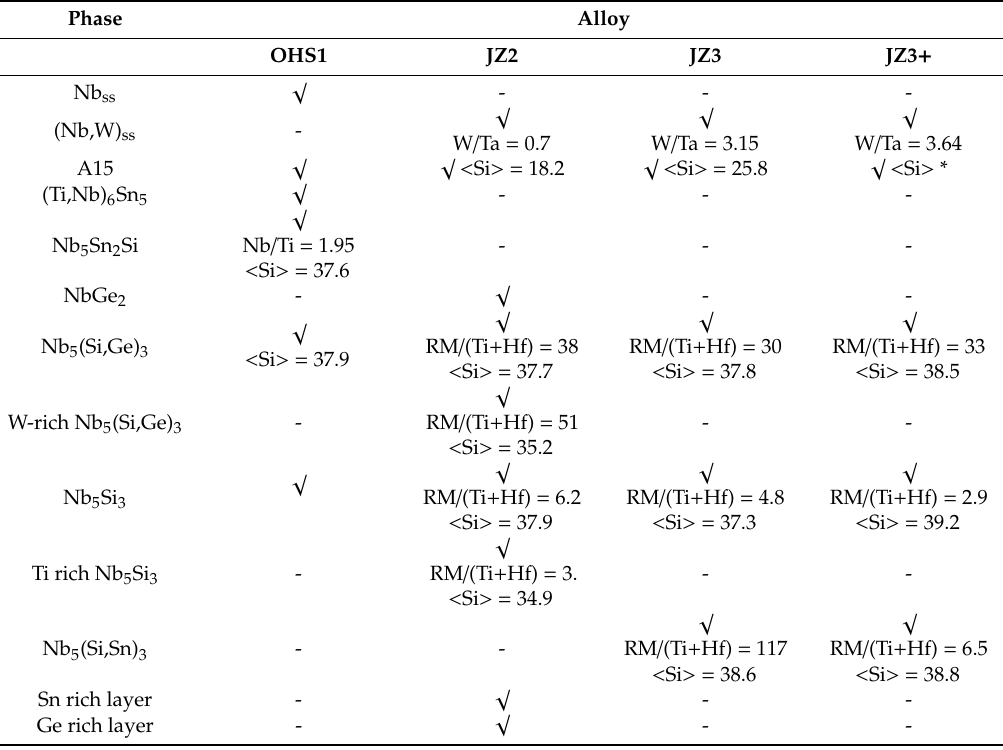
Table 7. Phases in the di ff usion zones of the alloys OHS1 [13], JZ2 [14], JZ3 and JZ3 + at 1200 ◦ C. √ The symbol means that a phase is present in an